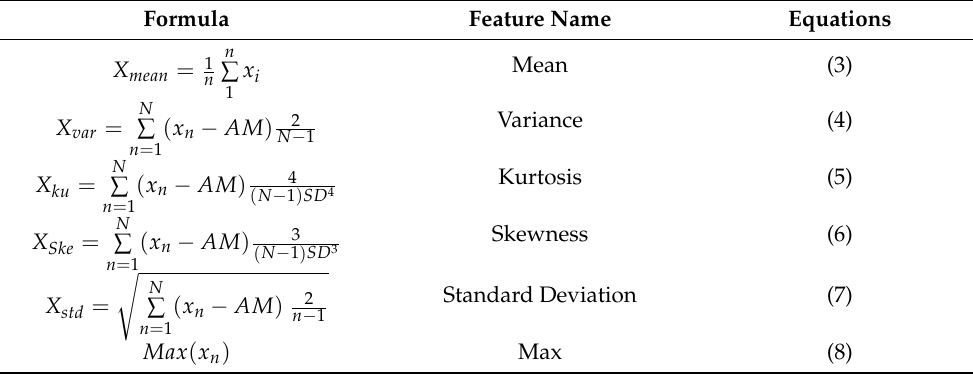
Table 4. Statistic features for epileptic seizure